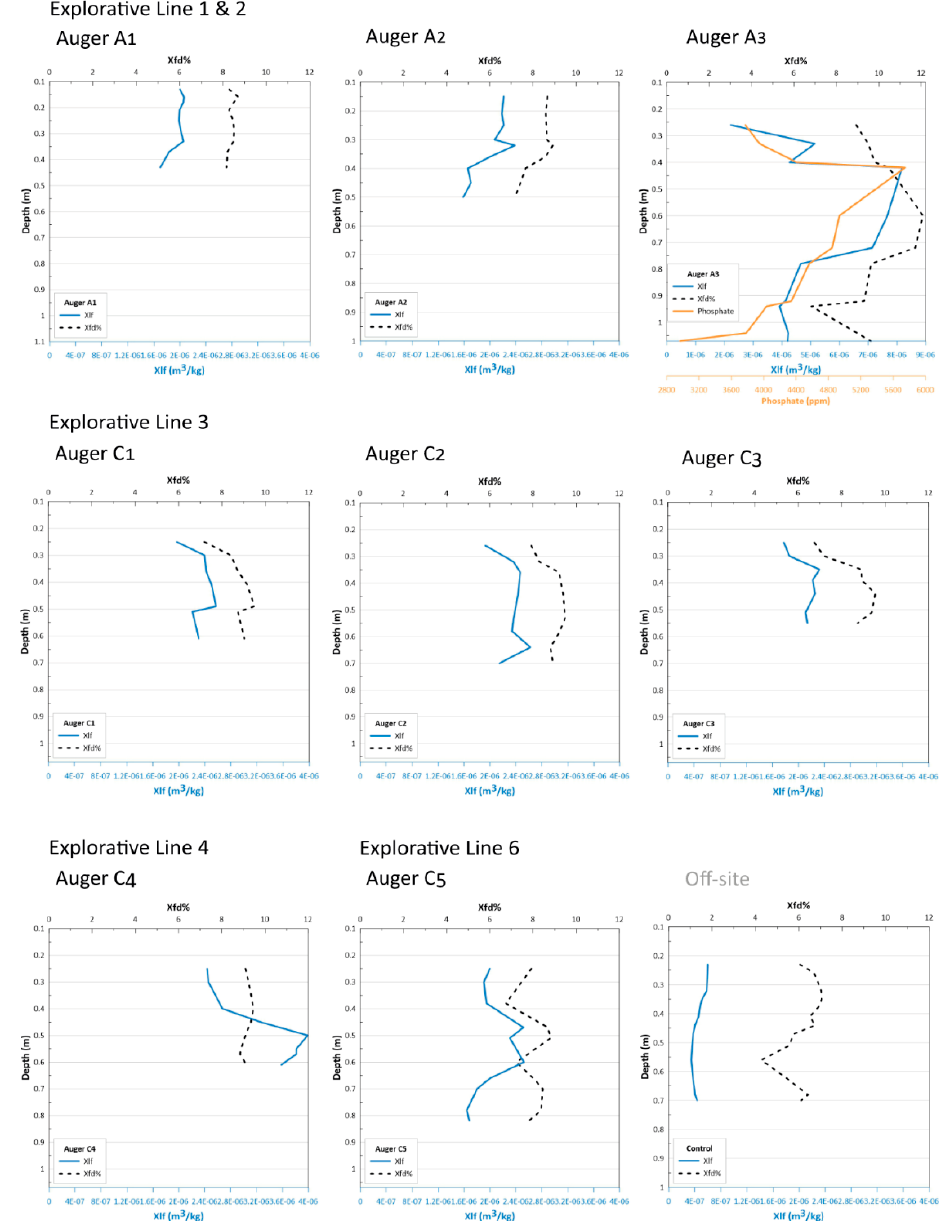
Figure 8. In-depth results of the low-frequency magnetic susceptibility ( χ lf) and frequency-dependent susceptibility (and phosphate only for A3) of the ‘auger’ samples and off-site controls at Almyriotiki. The location of the auger points in each exploratory line is shown in Figure 7.